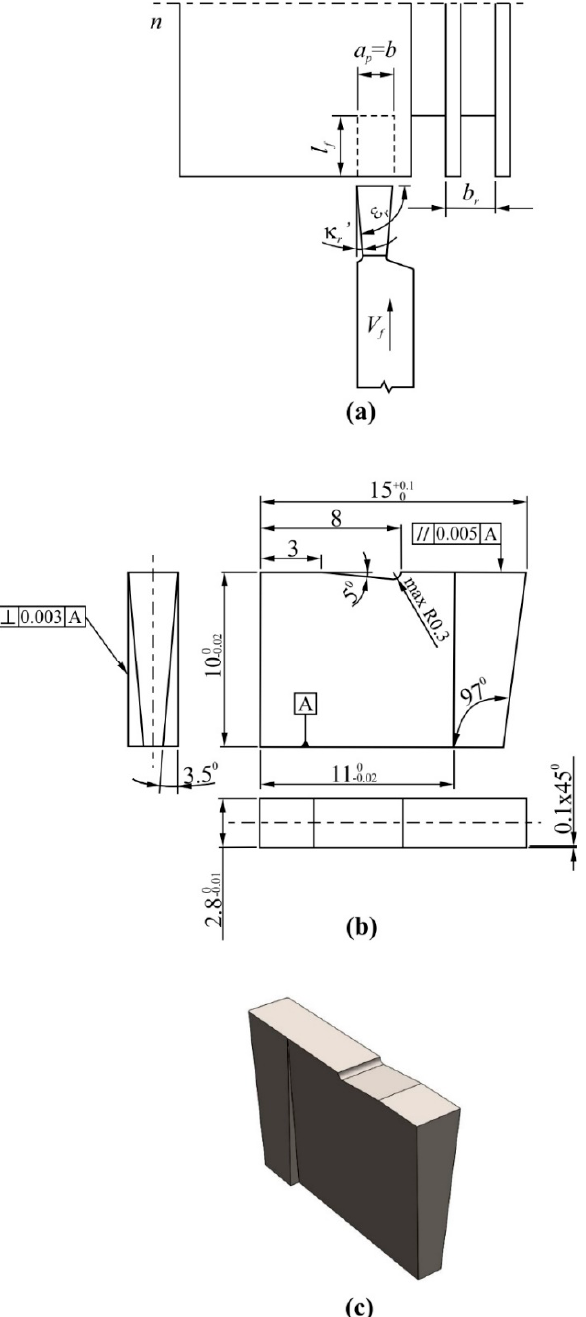
Figure 2. The grooving with DDCC inserts: ( a ) grooving kinematics, ( b ) geometry of tool (values given in millimeters) ( c ) cutting insert in isometric presentation.